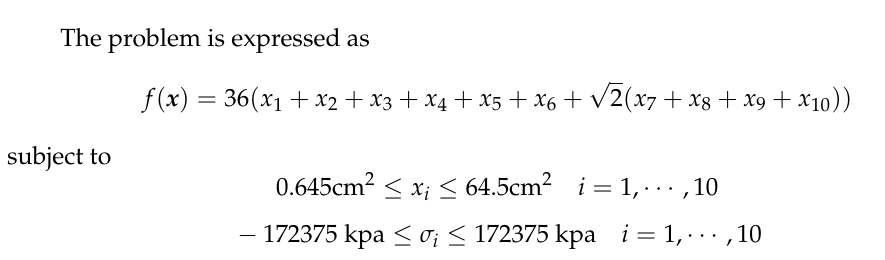
Figure 17. Ten-bar planar